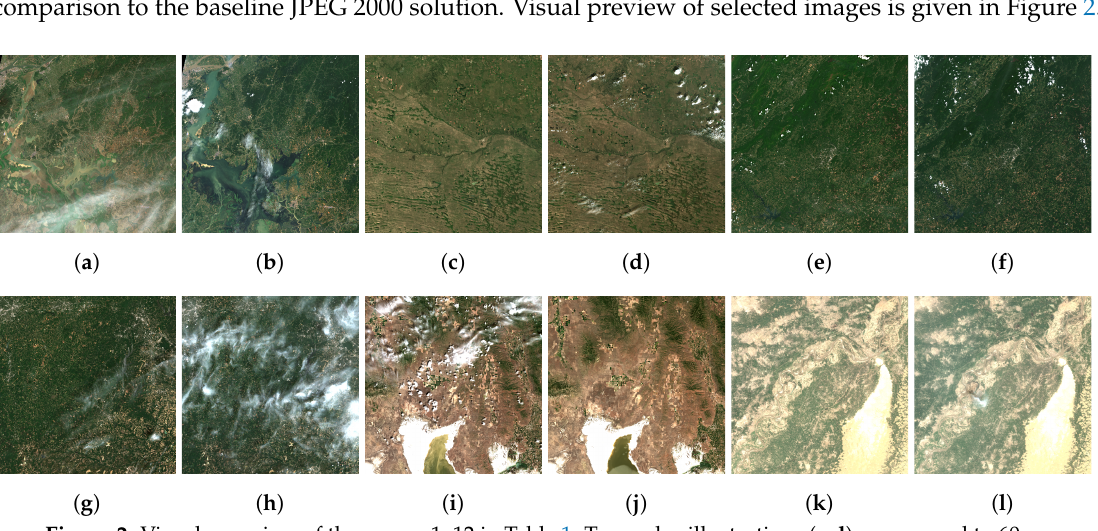
Figure 2. Visual overview of the scenes 1–12 in Table 1. True color illustrations ( a – l ) correspond to 60 m Sentinel-2 image channels. Some contain clouds and haze due to the adopted selection criteria which favours the Sentinel-2 images that were the ones closest in time to the original Landsat-8